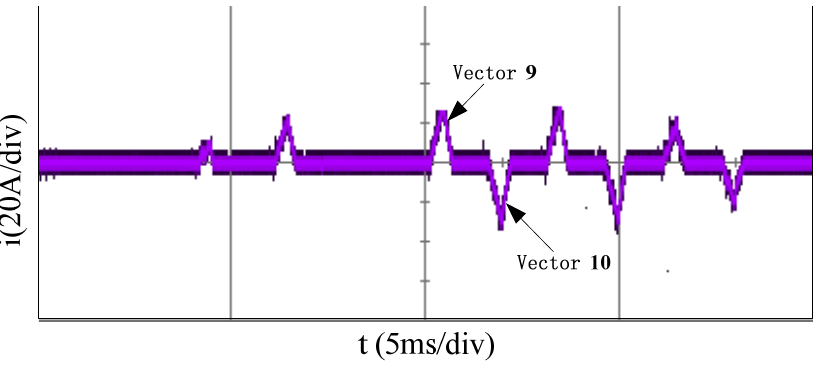
Figure 13. Current of the first series voltages. 0.15 times the reference